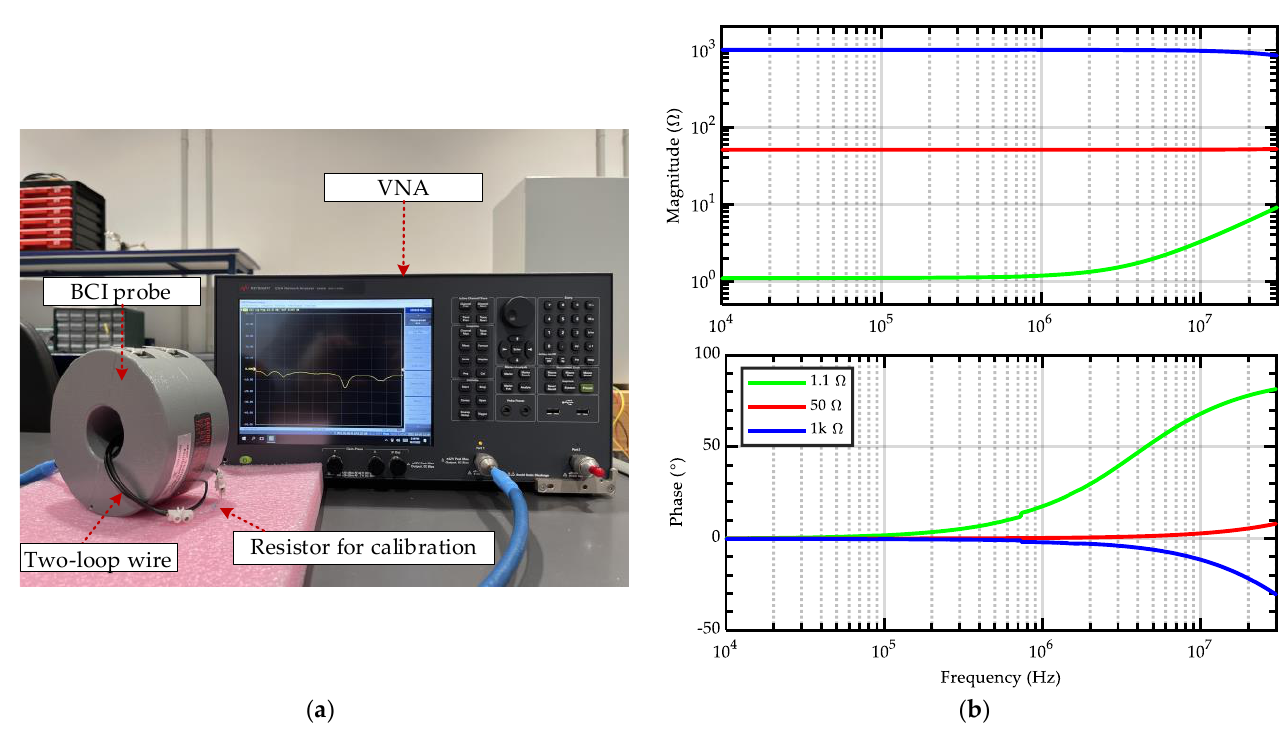
Figure 3. ( a ) Calibration setup and ( b ) measurements of the magnitude and phase of the three resistors used for calibration (obtained by reflectometric measure with impedance analyzer).